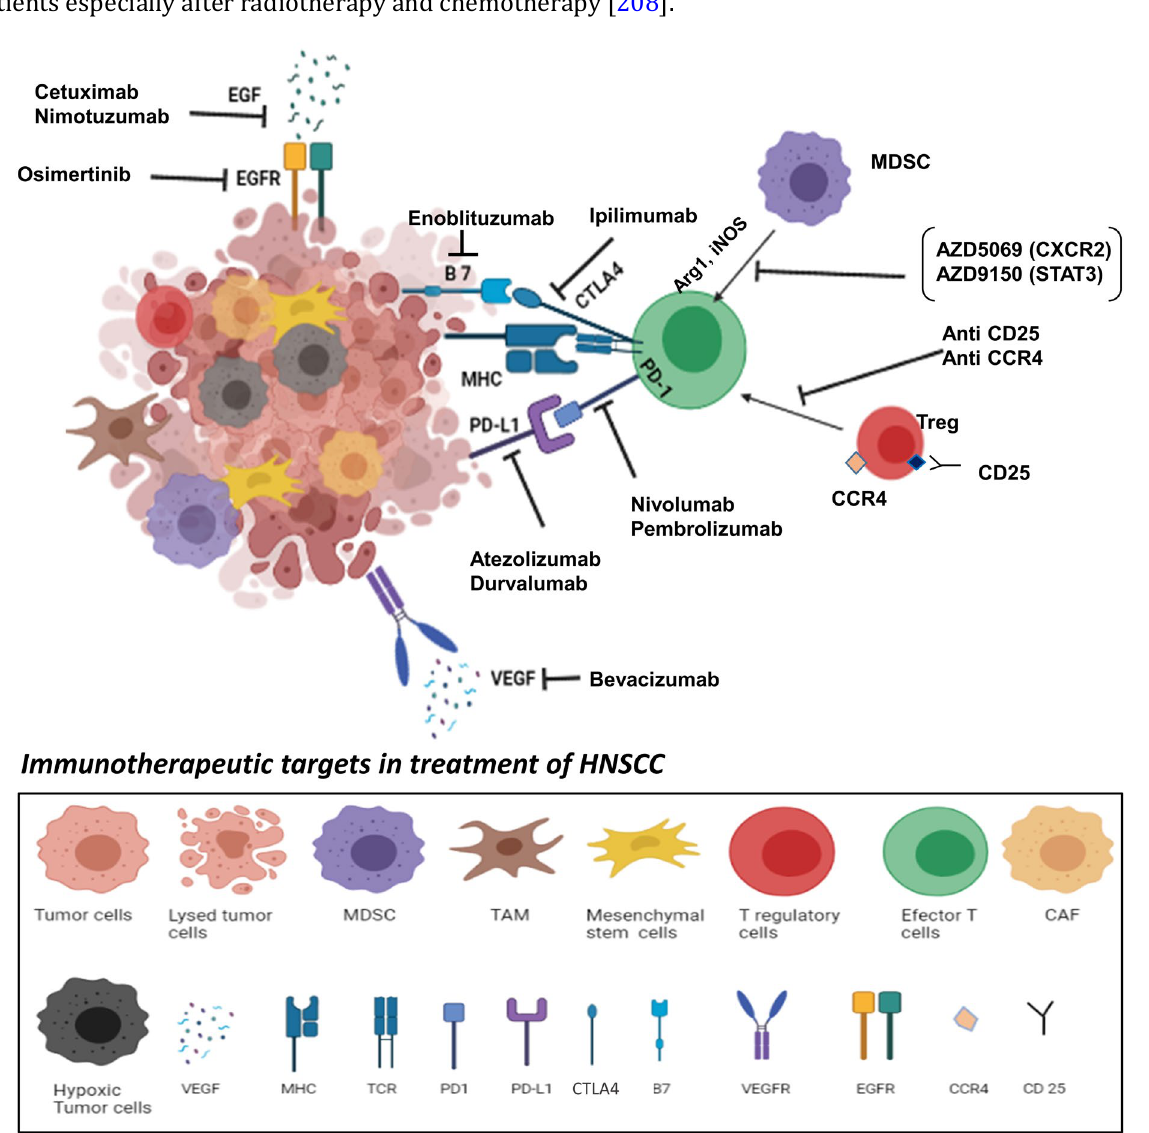
Figure 2. Immunotherapeutic targets in the treatment of HNSCC. Modification of immunosuppressive TME to favor anti-tumor immunity can be achieved by enhancing the infiltration of effector cells like CTLs and NK cells, APCs, or by blocking the activity of immunosuppressive cells like MDSCs, TAMs, and Tregs. Immune CPI based monoclonal antibodies: nivolumab (anti-PD-1), pembrolizumab (anti-PD-1), atezolizumab (anti-PD-L1), ipilimumab (anti-CTLA4), and durvalumab (anti-PD-L1) are being used as targeted treatment modalities that help in restoring functions of effector T cells. Danvatirsen (AZD9150) and AZD5069 which are STAT3 and CXCR2 inhibitors respectively are used to block the trafficking of MDSCs in TME. Cetuximab and nimotuzumab bind specifically to the EGFR on tumor cells to competitively inhibit the binding of EGF. In addition, osimertinib an EGFR tyrosine kinase inhibitor, directly blocks EGFR. Enoblituzumab recognizes B7-H3, a member of the B7 family of immune regulators, evoking an anti-tumor immune response. Bevacizumab, an anti-angiogenic drug, selectively binds to circulating VEGF and inhibits its binding to VEGFR on endothelial cells, limiting blood supply to tumor tissues. Antibodies against CCR4 and CD25 selectively deplete FOXP3 + Tregs which suppress the CTLs. Overpowering the suppressive effects of TME through immunotherapeutic